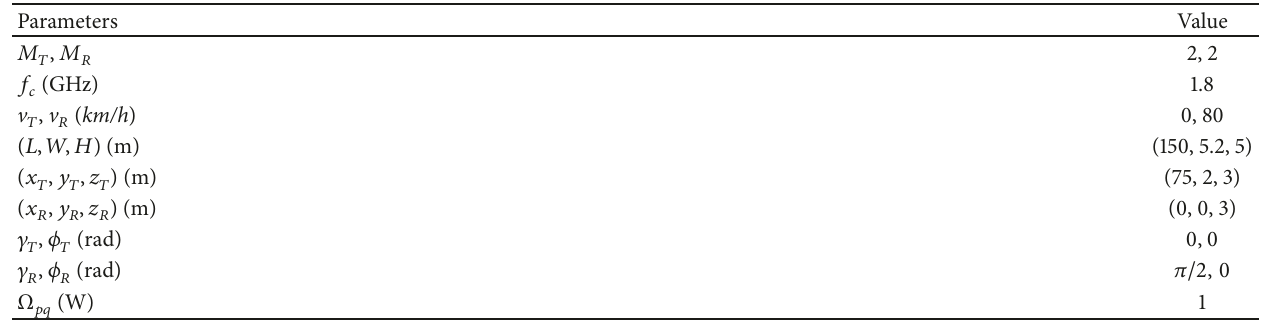
Table 2: Simulation